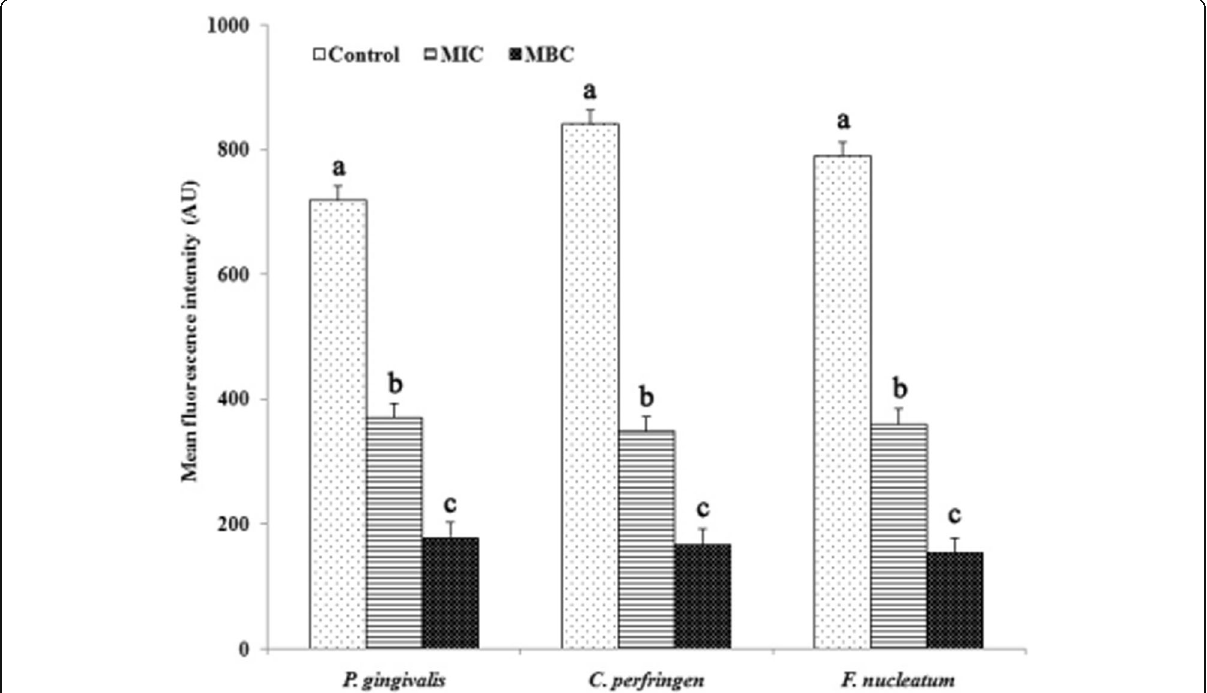
Fig. 4 Membrane potentials of P. gingivalis , C. perfringens , and F. nucleatum treated with ATS-80. ATS-80, 80% methanol-eluted fractions from alkali-treated quinoa saponin; MIC: minimum inhibition concentration; MBC: minimum bactericide